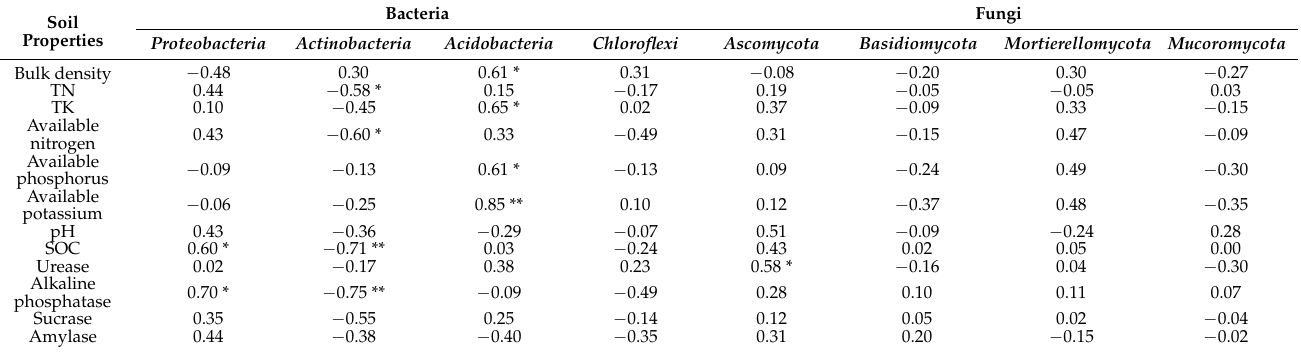
Table 4. Pearson correlation analyses of the relationships between soil physicochemical properties and the four most dominant